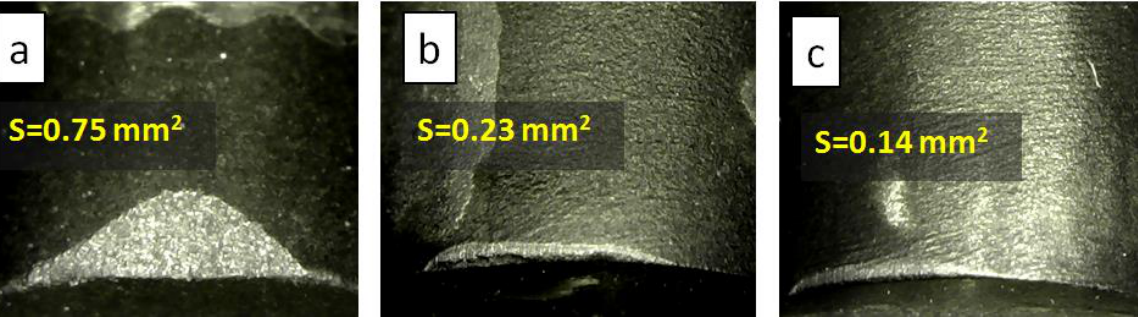
Figure 7. Photographs of wear spots of diamond composites taken after turning of white granite: ( a ) commercial PDC from US Synthetic; ( b ) composite obtained from a mixture of FDM-2Al-6Co; ( c ) nickel infiltrated FDM-2Al-6Co composite.